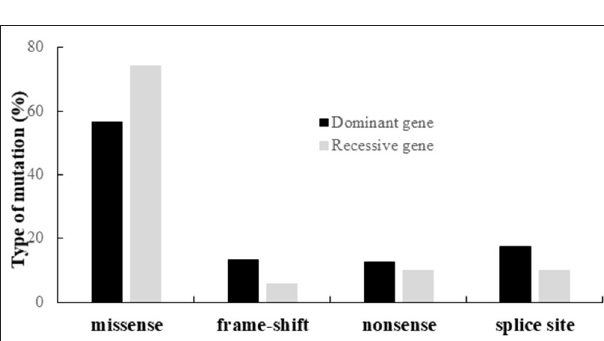
FIGURE 3 | Distribution of the different types of variants identified in the genes responsible for dominant or recessive IONs.